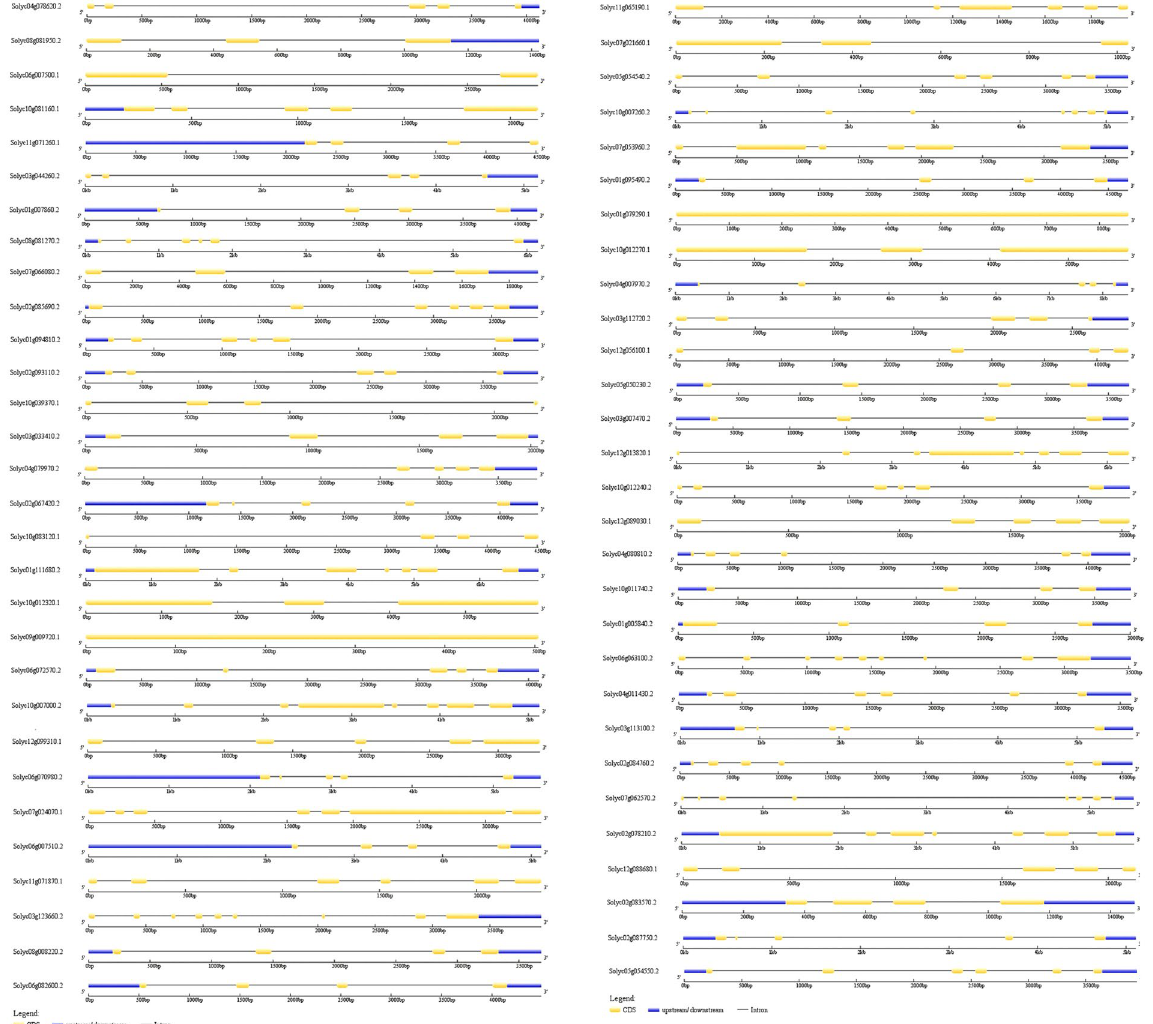
Figure 4. The exon/intron distribution of corresponding 59 identified tomato E2 enzymes was detected by comparing coding sequences (CDS) with their corresponding genomic sequences using GSDS tool online. The green box represents CDS; the blue boxes indicate upstream or downstream; the discontinuous lines refer to introns.